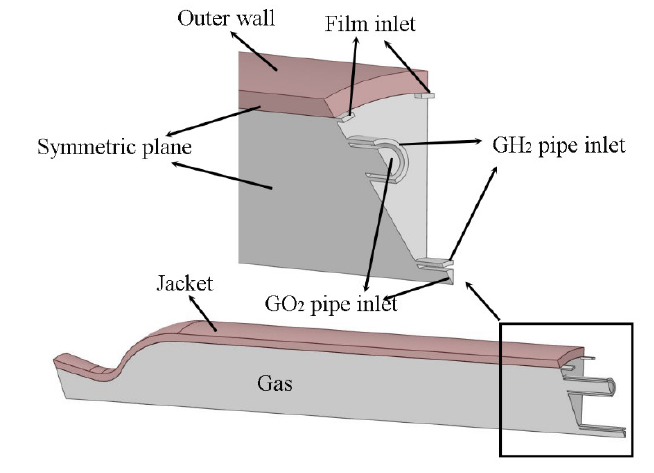
Figure 3. Computational domain.